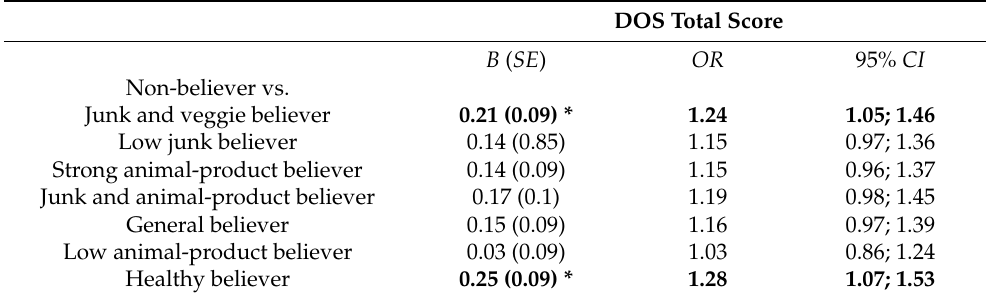
Table 6. Odds ratios dependent on DOS total score for being classified into a specific profile with the “NON-believer” profile as reference group. DOS Total Score B ( SE ) OR 95% CI Non-believer vs. Junk and veggie believer 0.21 (0.09) * 1.24 1.05; 1.46 Low junk believer 0.14 (0.85) 1.15 0.97; 1.36 Strong animal-product believer 0.14 (0.09) 1.15 0.96; 1.37 Junk and animal-product believer 0.17